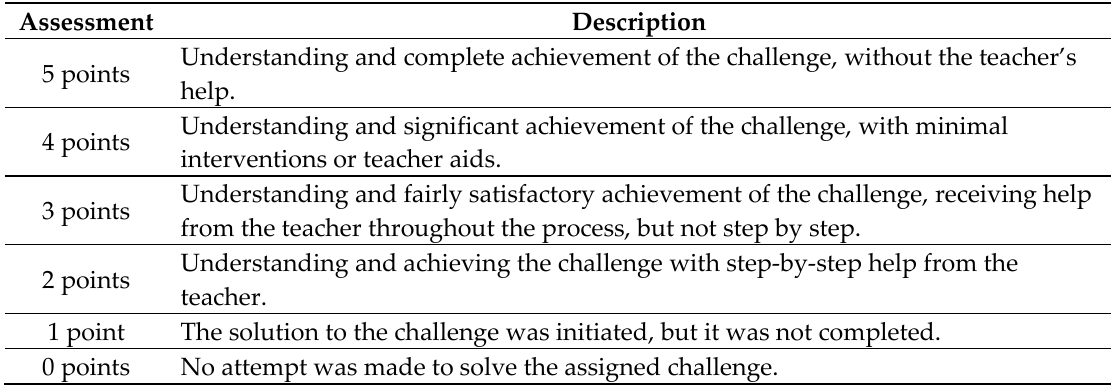
Table 2. Rubric for first grade.